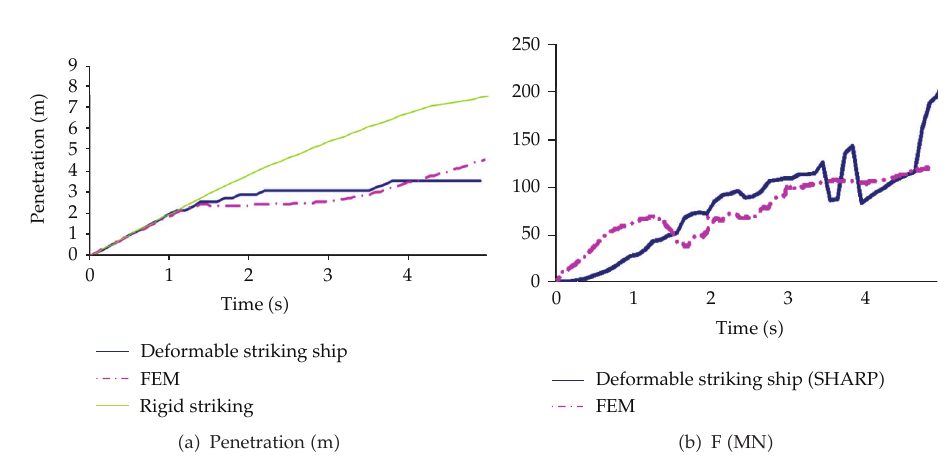
Figure 12: Time histories of penetration and total crushing force.